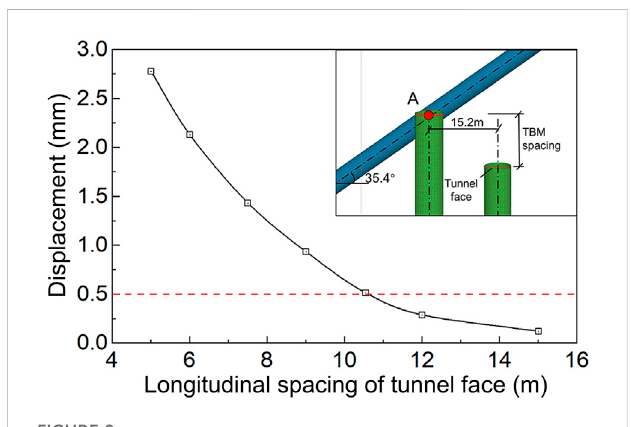
Curve of in fl uence of different distances of tunnel face on the displacement of tunnel ballast bed of operational tunnel during TBM tunneling.